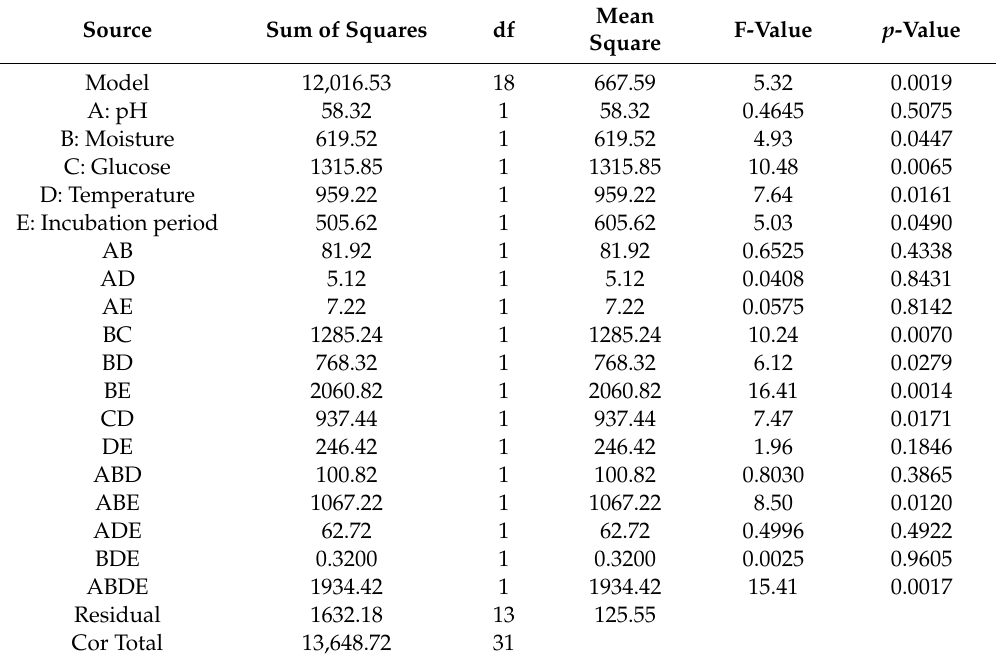
Table 2. Analysis of variance on biosurfactant production by B. subtilis strain Al-Dhabi-130 in two-level full factorial